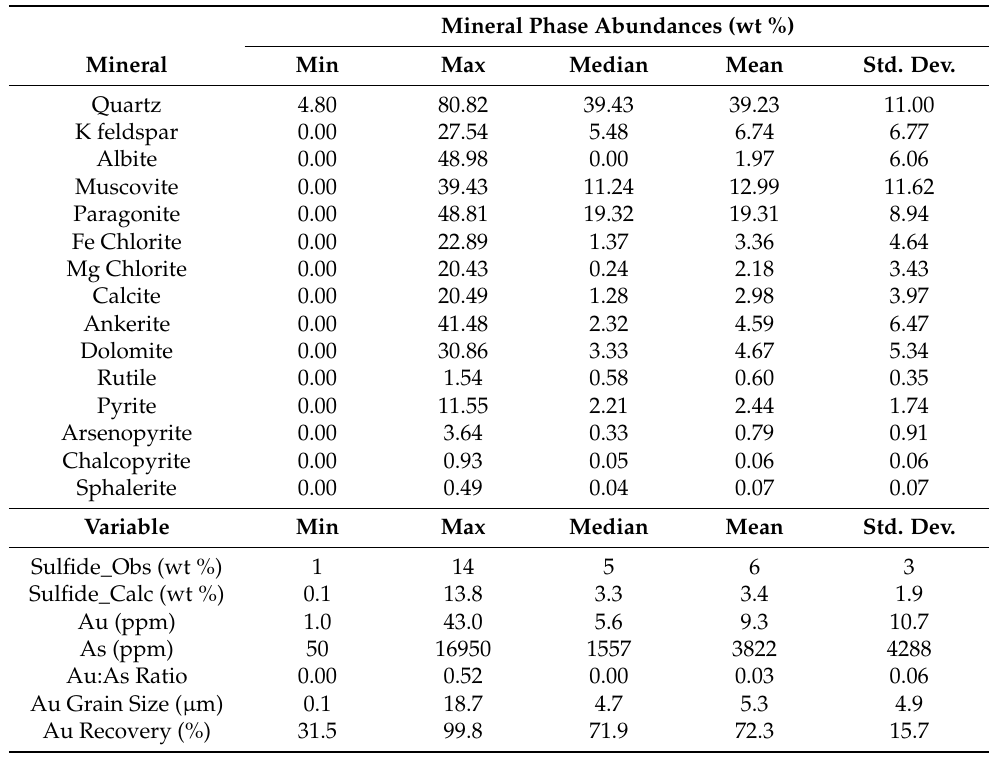
Table A3. Summary of descriptive statistics for mineral phase abundances, determined using